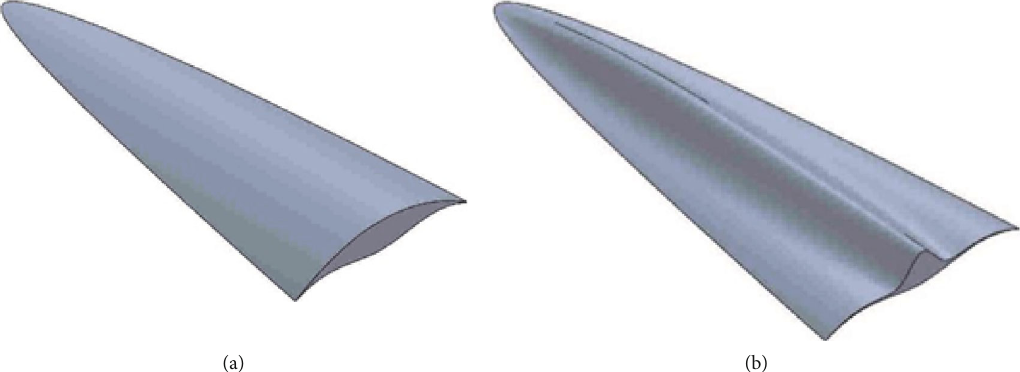
Figure 4: Isometric views of two sharp waveriders with di ff erent upper surfaces: (a) WR1; (b) WR2.